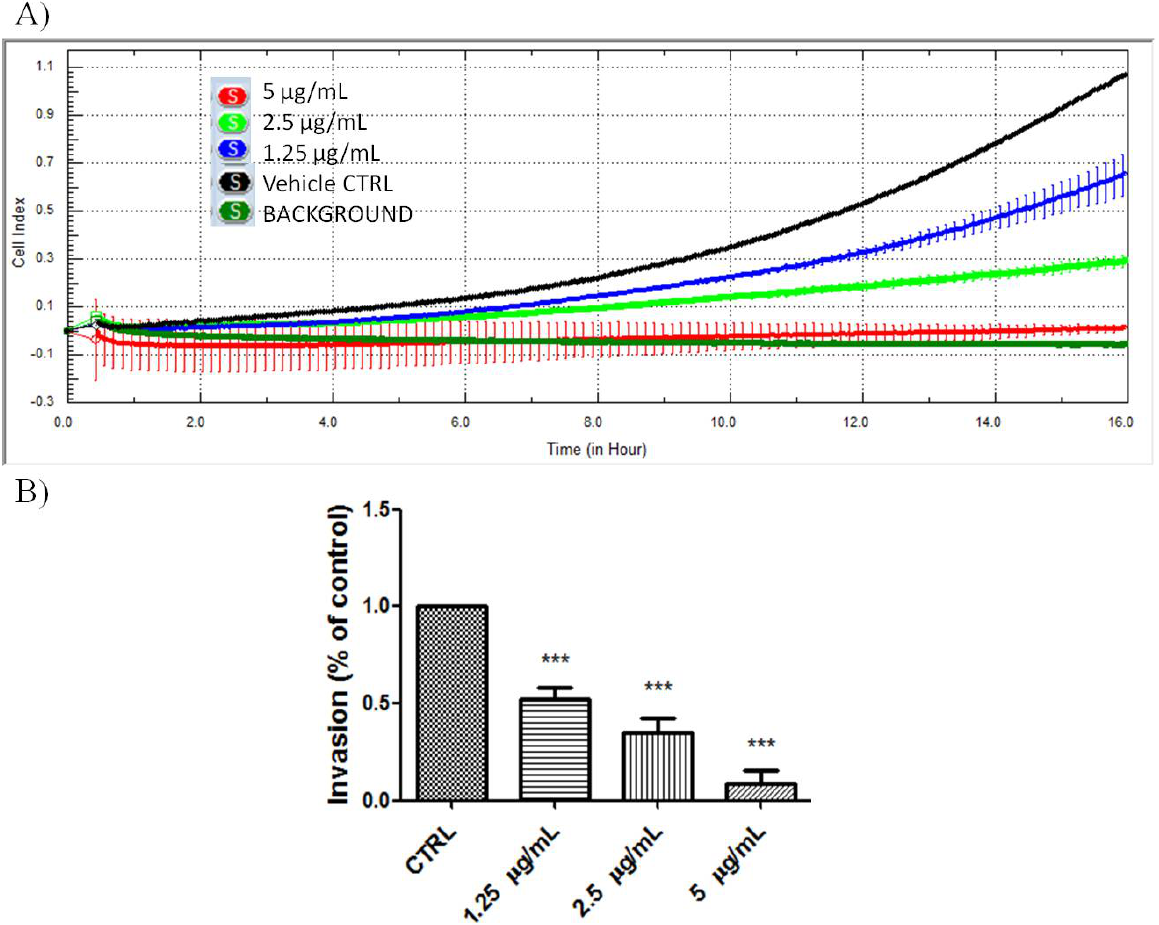
real-time A549 chemoinvasion profile; ( B ) PA treatment resulted in dose-dependent inhibition of A549 cell